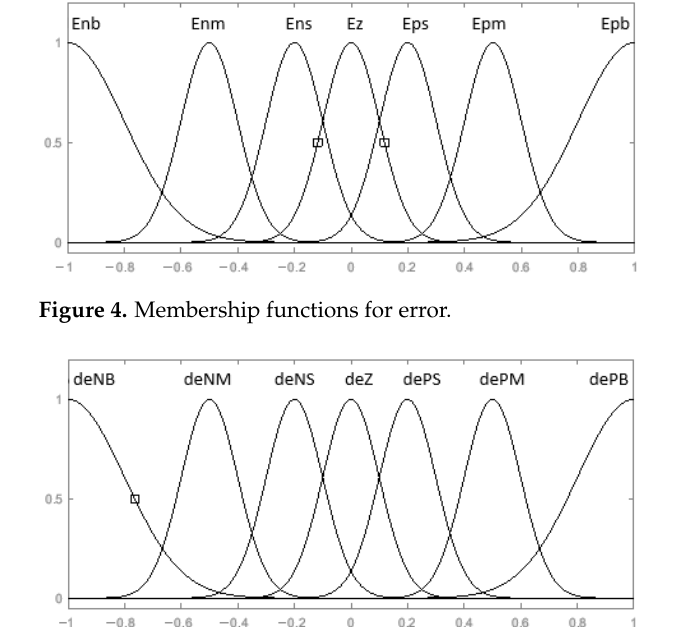
Figure 5. Membership functions for derivative of the error.